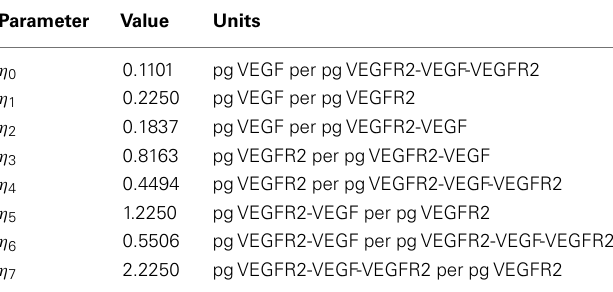
Table 1 | Parameter values relating to the molecular weights ofVEGF